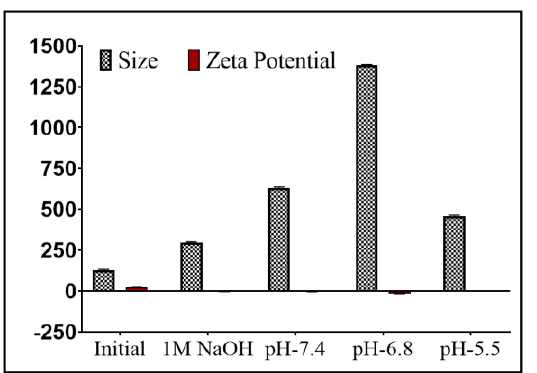
Figure 12. Particle size, PDI and zeta potential changes in MIL-101(Fe) after overnight incubation in different pH media.